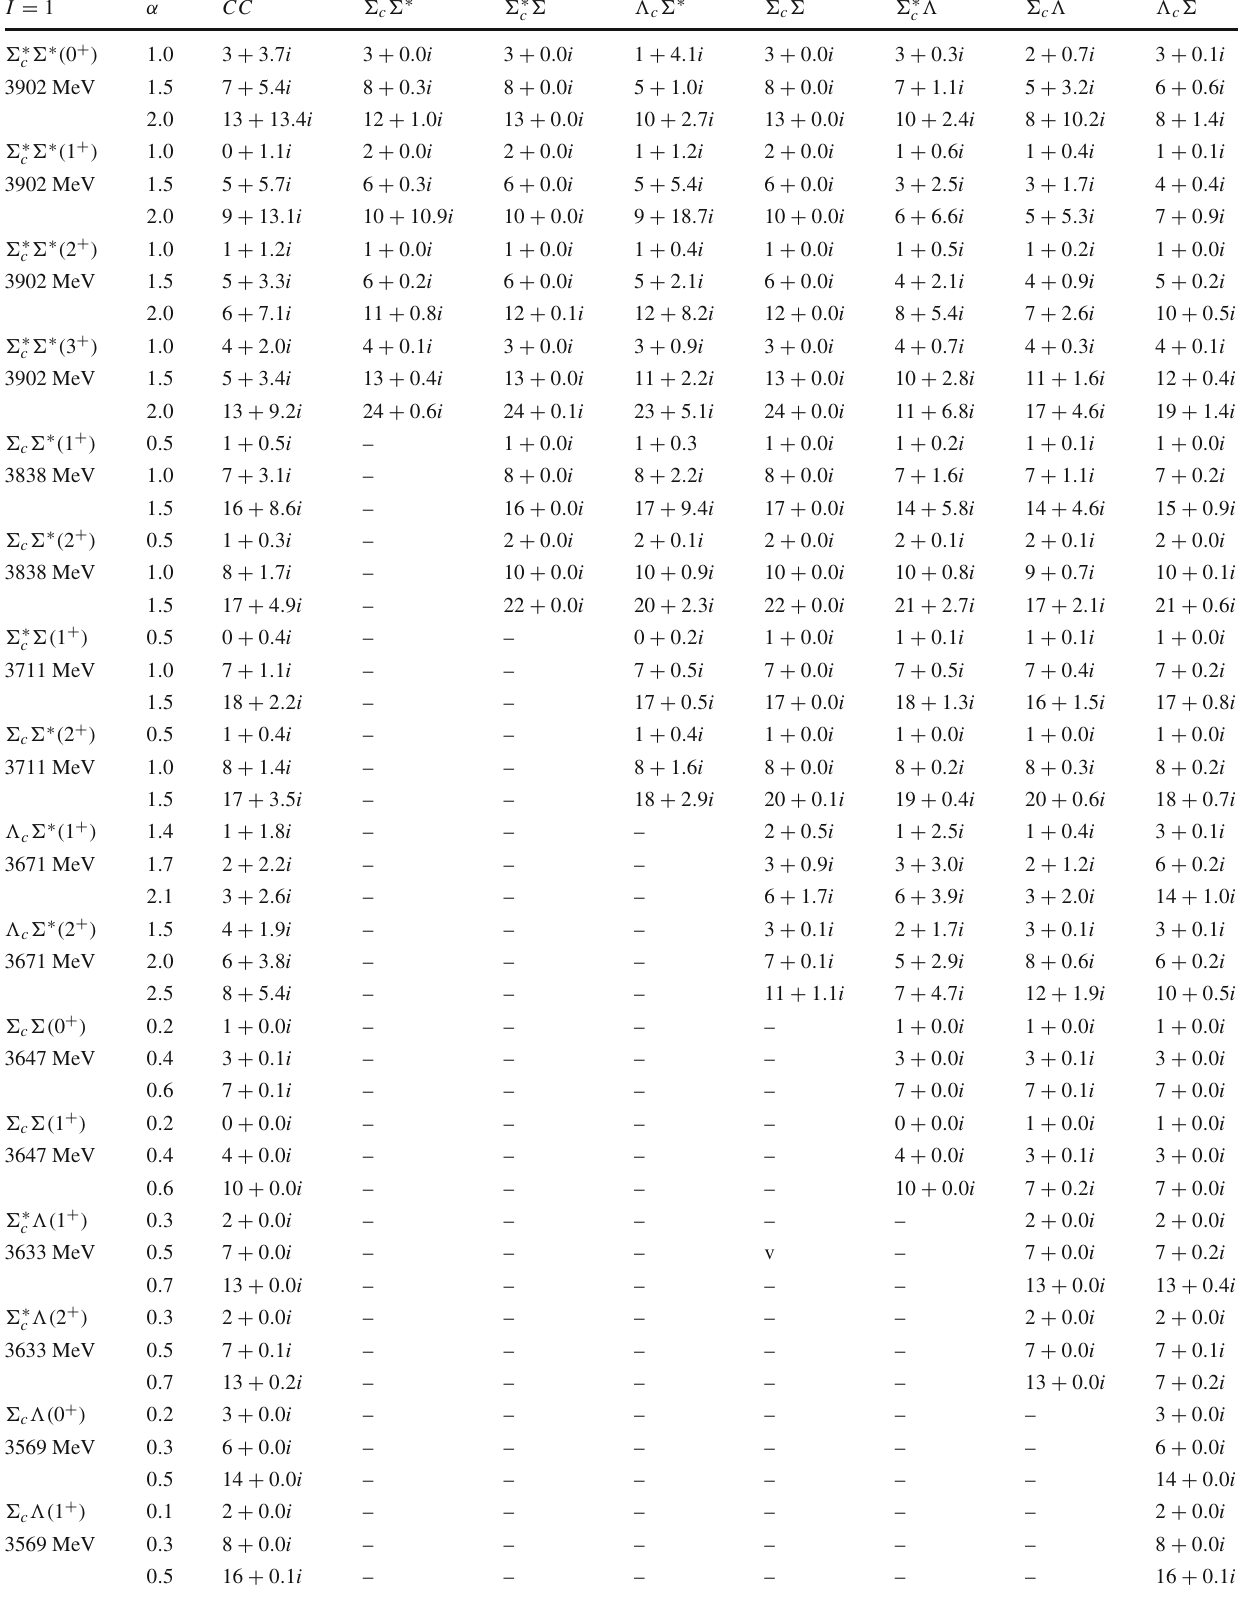
Table 5 The masses and widths of isovector charmed-strange molecular states at different values of α . Other notations are the same as Table